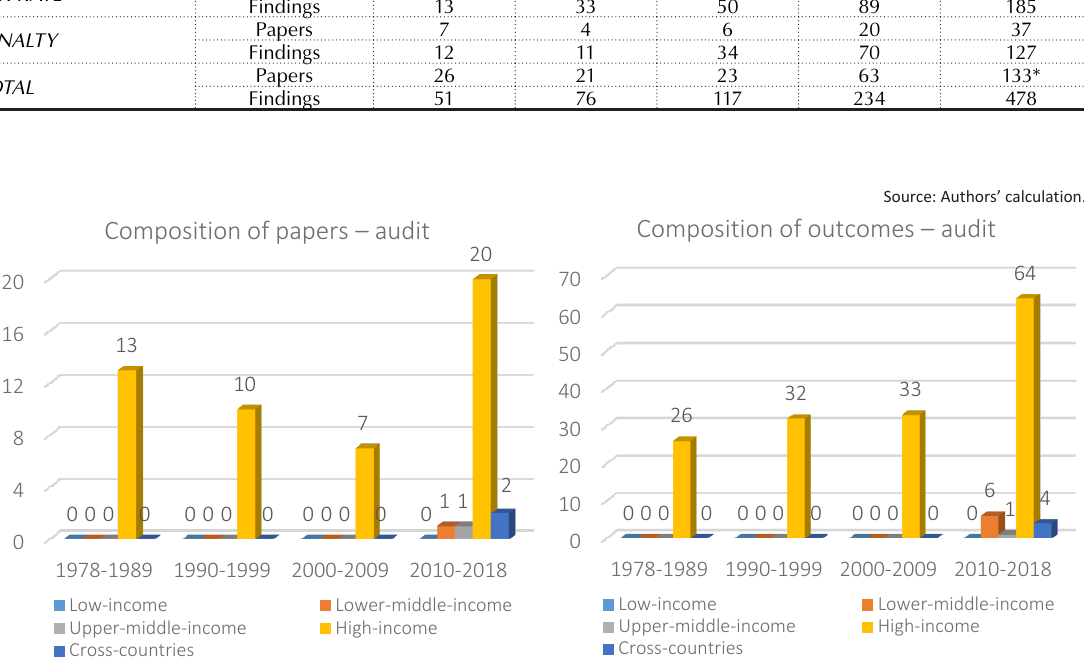
Figure 1. Composition of papers and outcomes –